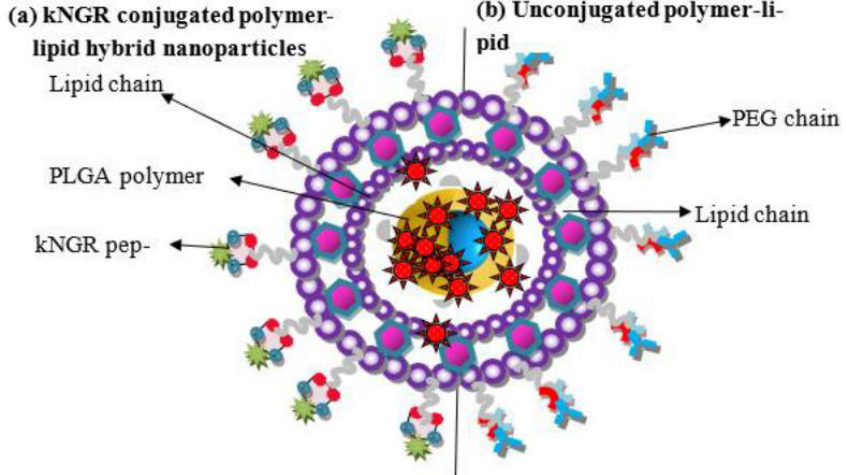
Figure 1. Structure of polymer–lipid hybrid NPs with schematic comparison of ( a ) kNGR-conjugated polymer–lipid hybrid NPs ( b ) unconjugated polymer–lipid hybrid NPs (Reused with permission from [49]. 2022 MDPI).